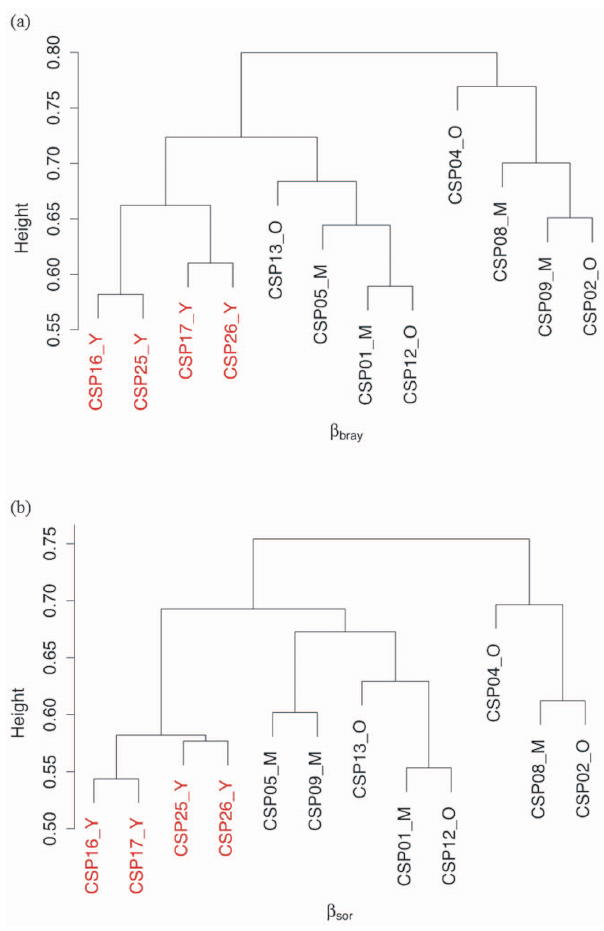
Figure 1. Complete hierarchical clusters based on pair-wise dissimilarity matrices derived from (a) abundance based Bray- Curtis dissimilarity matrix ( b bray ) and (b) incidence based Sorenson dissimilarity matrix accounting for beta diversity ( b sor ). Both cluster diagrams showed that the observed significant effect of forest age to the fungal alpha (adonis R 2 =0.235, P , , 0.01) and beta diversity (adonis R 2 =0.231, P , 0.05) differences is mainly attributed to the fungal communities of the young age class